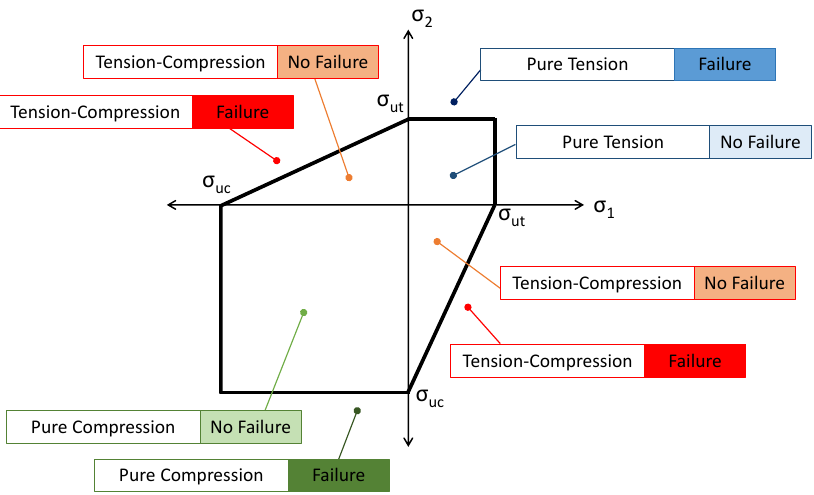
Figure 7. Mohr–Coulomb failure criterion with all possible states of stress.